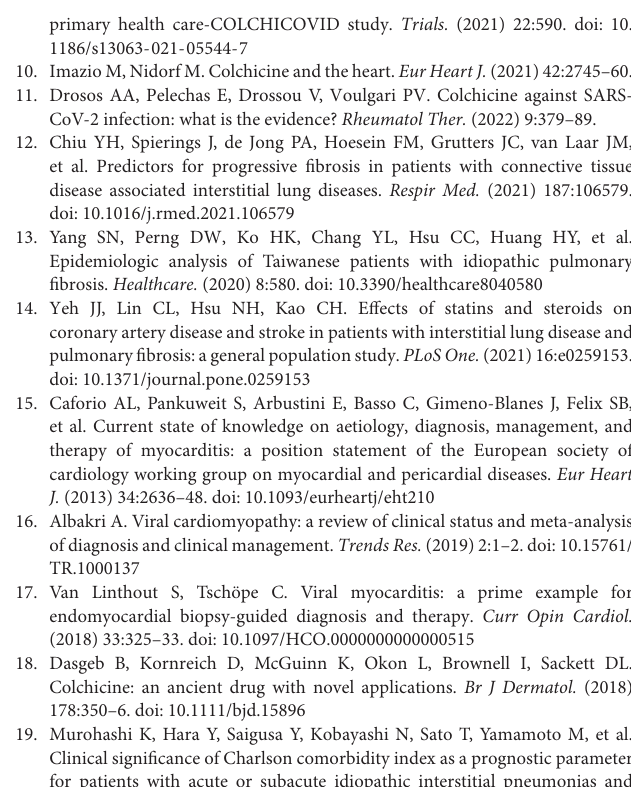
Supplementary Figure 1 | Speculations intertitial lung disease, virus, heard disease coxesit, and interplay with NLRP3